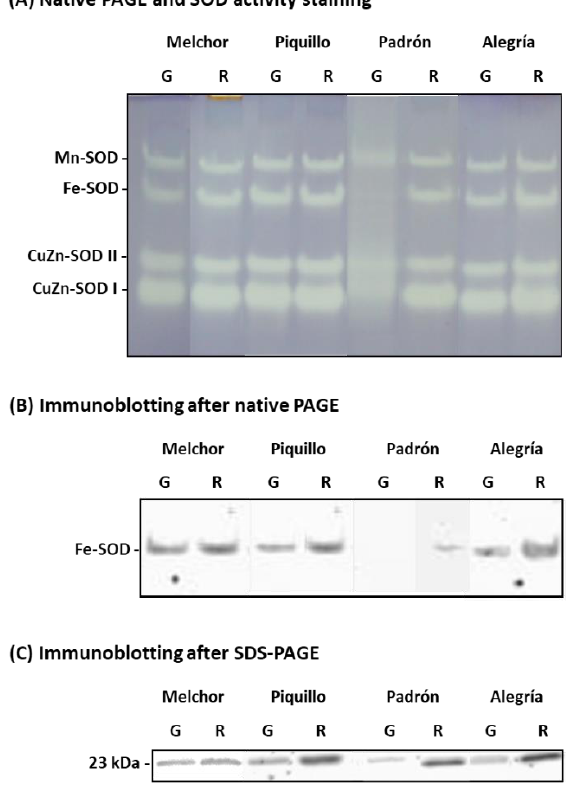
Figure 5. Isoenzymatic superoxide dismutase (SOD) pattern in pericarp from fruits of four pepper varieties at two ripening stages. ( A ) Native PAGE on 10% acrylamide gels and further in-gel SOD activity staining by the NBT reduction method; 34 μg protein per well was loaded. ( B ) Immunoblotting after native PAGE on 10% acrylamide gels. ( C ) Immunoblotting after SDS-PAGE on 12% acrylamide gels. In both immunoblotting assays, an antibody against Fe-SOD from pepper fruits (dilution 1:5000) was used. In panel B, the mobility of the detected bands was similar to the one observed for Fe-SOD in panel A. The monomeric molecular size of the cross-reacting bands (23 kDa) is indicated on the left in panel C. Data are representative of at least three independent experiments where different samples from each variety and ripening stage were used. G, green fruits. R, red fruits.